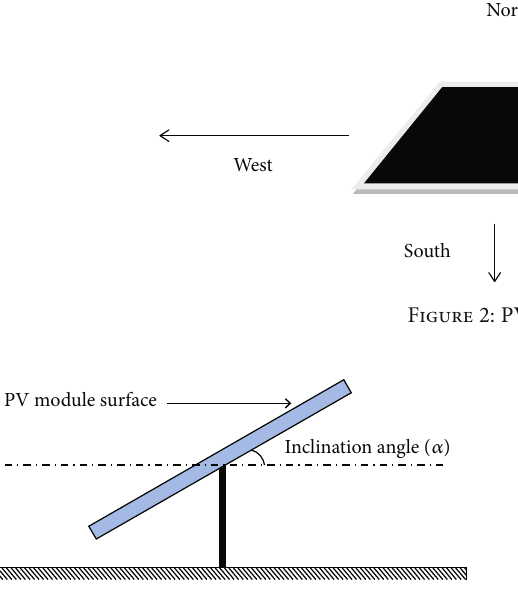
Figure 3: Angle of inclination of photovoltaic